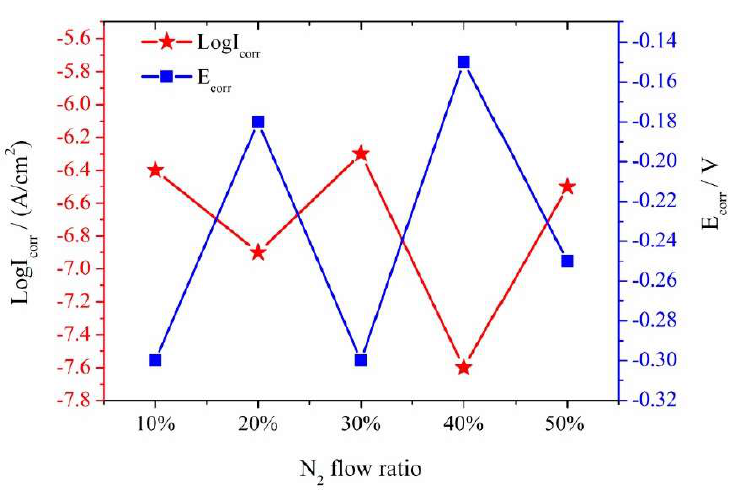
Figure 10. Relationship between the self-corrosion potential (E corr ) and the corrosion current density (I corr ) of NbTiAlSiZrN x HEA films with R N [54] (Creative Commons Attribution 4.0 International License).